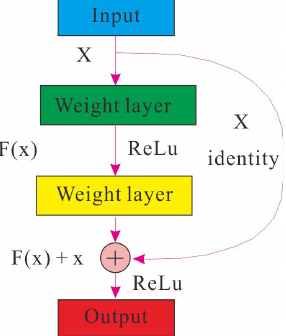
Figure 4. Residual block